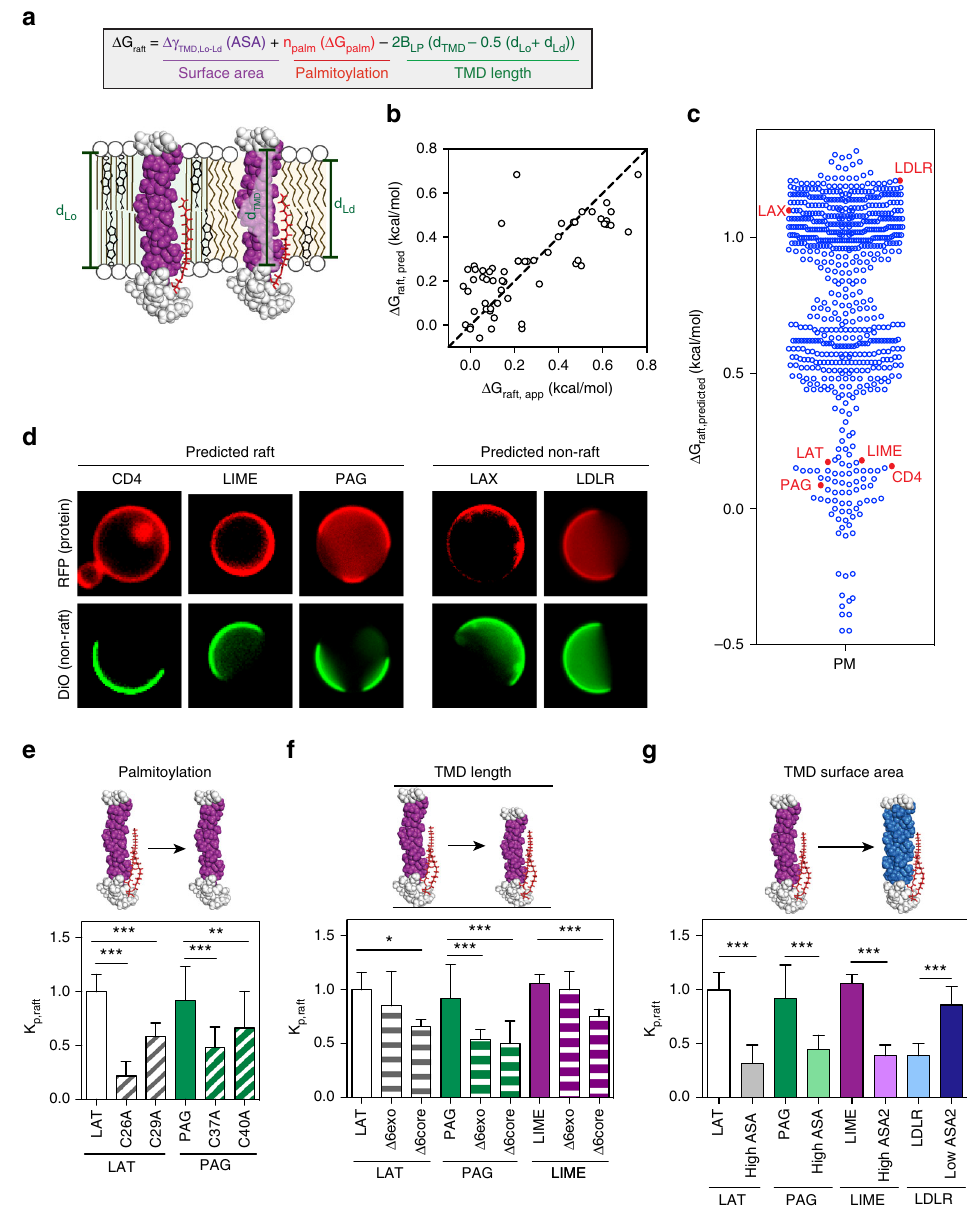
Fig. 3 Construction of a comprehensive, predictive raft partitioning model. a TMD length and palmitoylation have been previously identi fi ed as determinants of raft partitioning. These have been formalized together with the surface area model from Fig. 2 into a comprehensive description of raft partitioning for TMDs. b Using parameters derived from published data and Fig. 2, raft af fi nity predicted from the tripartite model ( Δ G raft,pred ) shows excellent agreement with measured values ( Δ G raft,app ) for all tested TMDs (i.e., the constructs from Fig. 2a plus 4 palmitoylation mutants and 4 TMD truncations) without any fl oating fi t parameters. c The model was used to predict raft af fi nity for the 729 single-pass PM proteins in the human proteome, from which three were chosen as representative raft-preferring proteins and two as non-raft preferring. d The partitioning of constructs containing TMDs from these fi ve proteins followed predicted trends, with all three raft-predicted TMDs (CD4, LIME, PAG) partitioning ef fi ciently to the raft domains, while both predicted non-raft proteins (LAX and LDLR) showed minimal raft partitioning. Vesicles in images are 5 – 10 μ m in diameter. e - g The characteristics determining the raft partitioning of these constructs were dissected by mutating the TMDs to modify palmitoylation, TMD length, and ASA. e Mutating either of two palmitoylation sites reduced raft partitioning for LAT and PAG; f truncating the TMD length by 6 amino acids reduced raft partitioning for LAT, PAG, and LIME (but not LIME- Δ 6exo); and g increasing ASA reduced raft partitioning for PAG and LIME, while decreasing ASA signi fi cantly increased raft partitioning for LDLR. Average ± SD for 3 – 5 independent trials, each with > 10 vesicles/condition; * p < 0.05; ** p < 0.01; *** p < 0.001, one-way ANOVA. Sequences and partitioning values for all variants are given in Supplementary Tables 3,